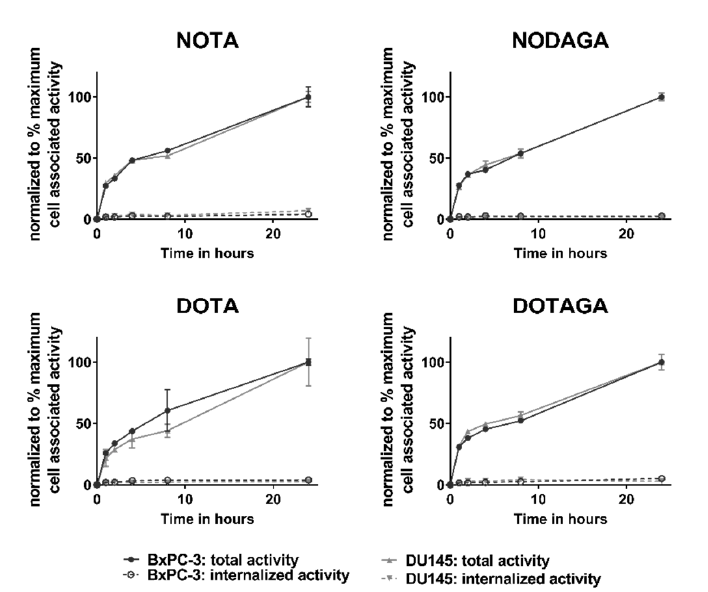
Figure 3. Internalization assay in BxPC-3 cells (black) and DU145 (grey) cells. Fractions of internalized and cell-associated activity of [ 57 Co]Co-(HE) 3 -Z HER3 -X are shown as normalized to the maximum cell-associated activity. Each data point is the average of three dishes ± SD, n = 3.